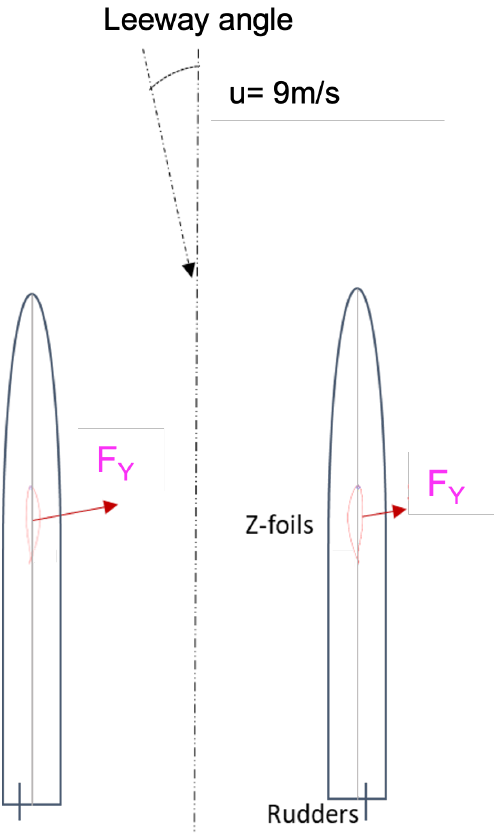
Figure 4. NACRA 17 schematics of side force generation from the leeward and windward